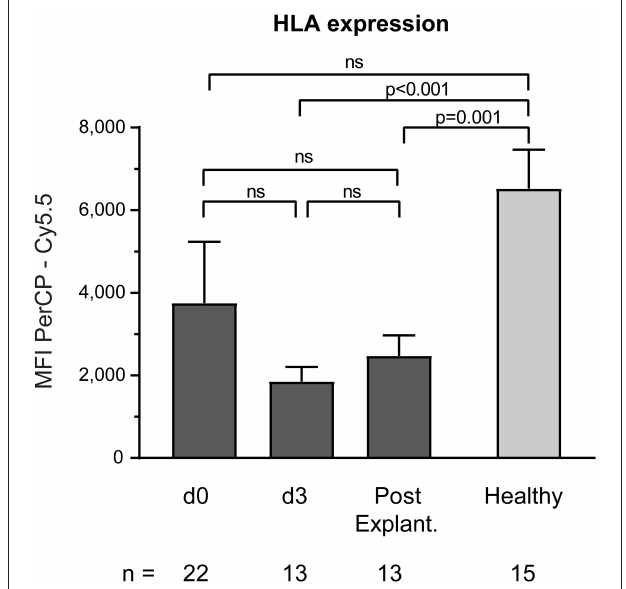
FIGURE 4 | Baseline monocyte HLA expression on CD14 + monocytes. The number of remaining patients analyzed at each time point during VA-ECMO therapy (d0, d3) and after explantation (post explant.) is presented below the individual bars. HLA expression was quantified as the mean fluorescence intensity (MFI) in the PerCP—Cy5.5 channel and was measured in phosphate buffered saline treated samples as described in the Materials and Methods section. ns, not significant. Mixed effects models were used to analyze differences between means across different time points (d0, d3, and post explantation vs. each other). Unpaired t -tests were used to analyze differences of means at single time points. Data are presented as mean ± SEM.